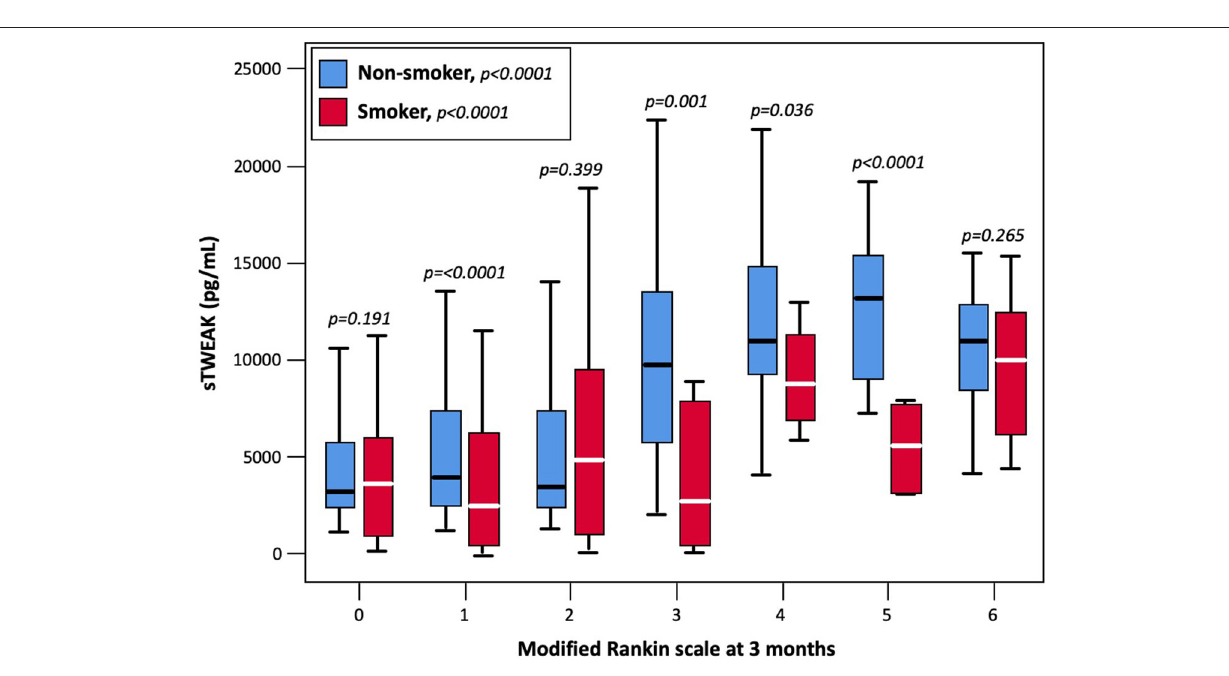
FIGURE 3 | Basal sTWEAK concentrations at different points of the modified Rankin scale at 3 months in smoker and non-smokers